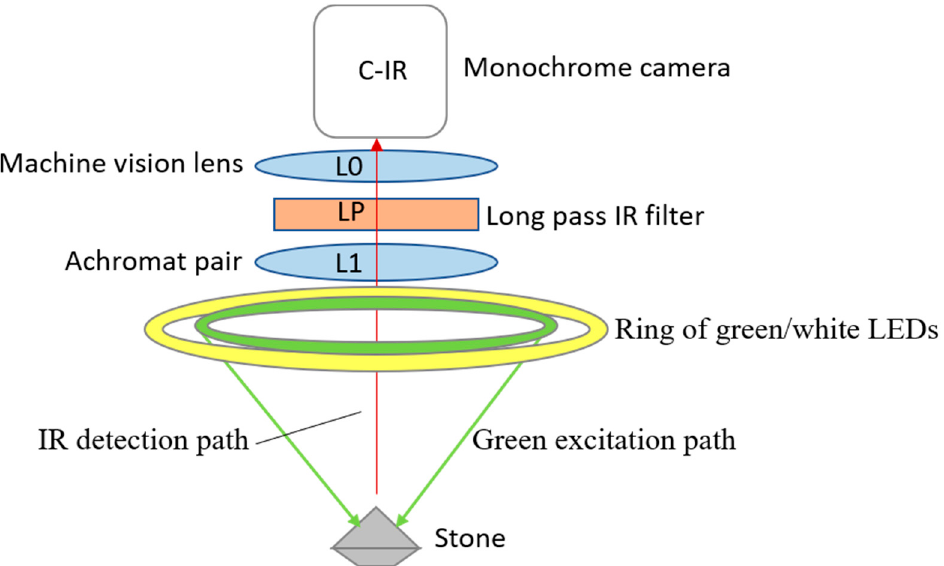
Figure 2. Schematic of ×0.25 magnification imaging system for capture of near IR luminescence from Cubic Zirconia (CZ). L0 = F#1.4 25mm lens (HF25HA-1S Fujinon, Fujifilm, Tokyo, Japan), L1 = 2 mm × 200 mm achromats (200DQ25, Comar Optics Ltd, Cambridge, UK), LP = 808 nm cut-off infrared long pass filter (BLP01-808R-25, Semrock, IDEX Health & Science LLC, New York, NY, USA), C-IR =